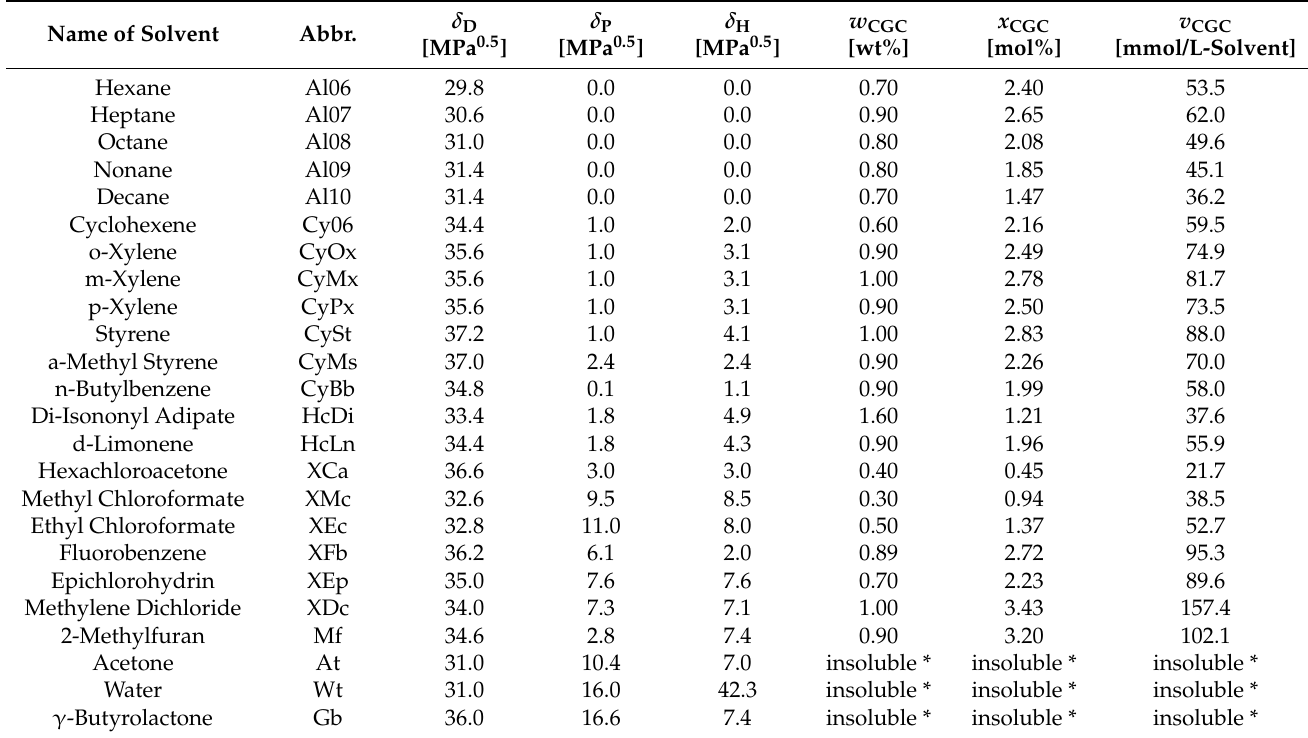
Table 1. List of solvents used in this work with their HSP [30] and